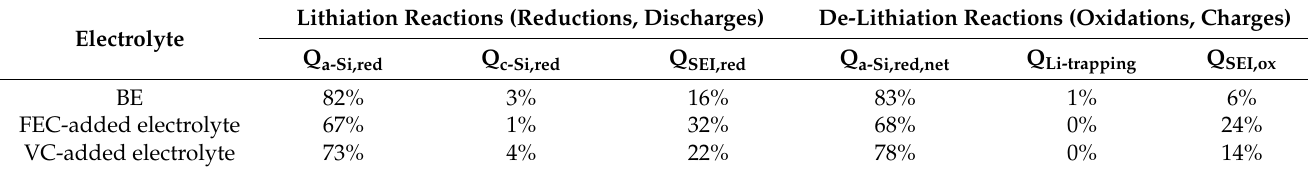
Table 2. Decoupling of the various sources of capacity during the first 5 cycles for the three different electrolytes (% of the total cumulative capacities in cycles